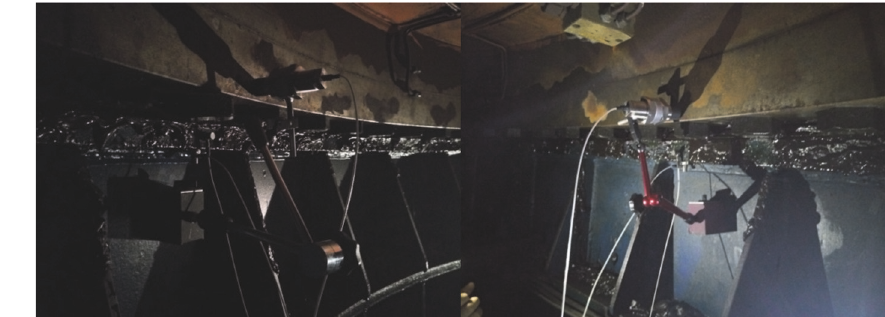
Figure 2: Arrangement of sensors.